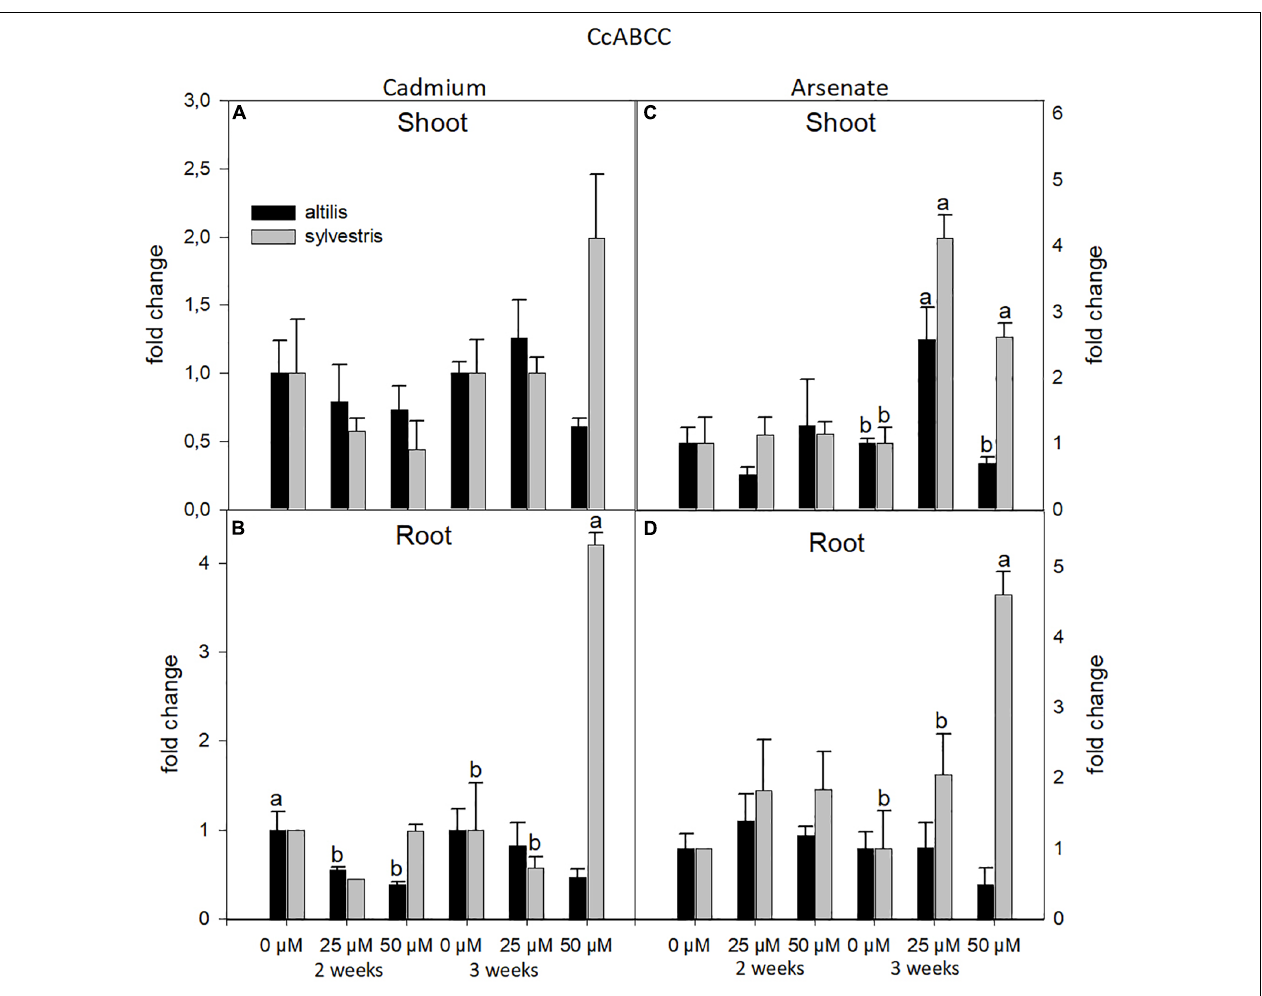
FIGURE 8 | The level of gene expression of ABCC in seedlings of altilis and sylvestris grown up to 2 and 3 weeks under Cd (A,B) and As (C,D) at different concentrations. The fold change is the Ct value with respect to the housekeeping genes (EF1 α and GAPDH) that is considered 1. The error bars represent the error mean of three biological replicates. Letters indicate only significantly different values ( P ≤ 0.05) between concentrations in each moment of sampling.